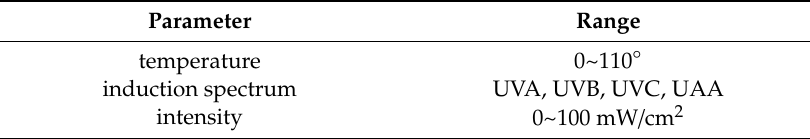
Figure 1. Measuring instruments: ( a ) EIT UV Power Puck, ( b ) Model of type A in actual process, ( c ) The light source is 8 cm away from the UV intensity sensor, and the exposure product has the same placement as it. Table 1. Technical specifications of the UV intensity sensor.